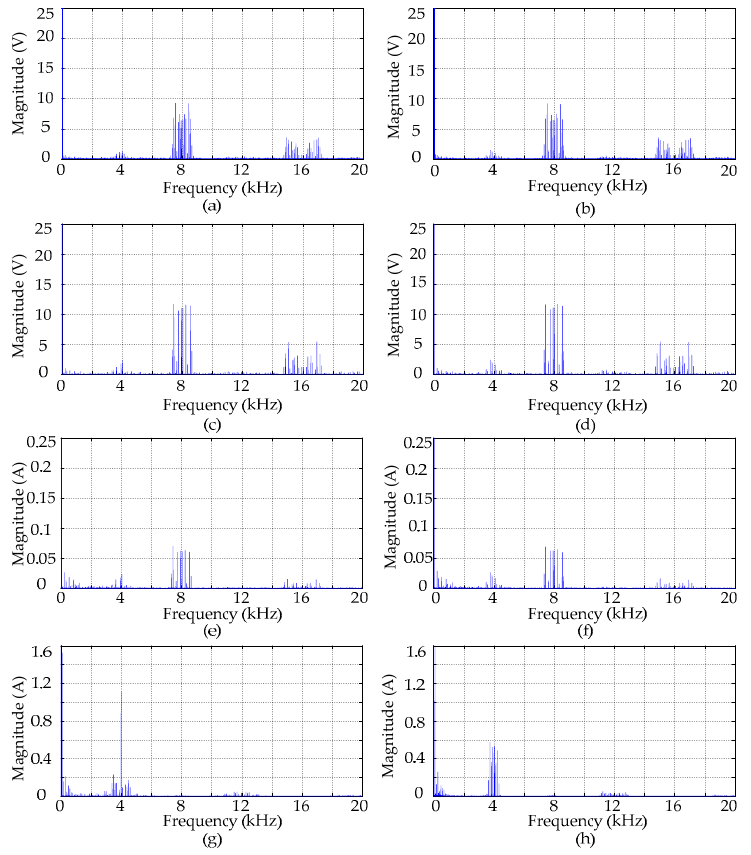
Figure 14. Harmonic spectra of experimental results for DCPDPWM and PSCPWM methods with output voltage harmonics minimization scheme: ( a ) phase voltage of DCPDPWM; ( b ) phase voltage of PSCPWM; ( c ) line-to-line voltage of DCPDPWM; ( d ) line-to-line voltage of PSCPWM; ( e ) phase current of DCPDPWM; ( f ) phase current of PSCPWM; ( g ) circulating current of PDPWM; and ( h ) circulating current of PSCPWM.